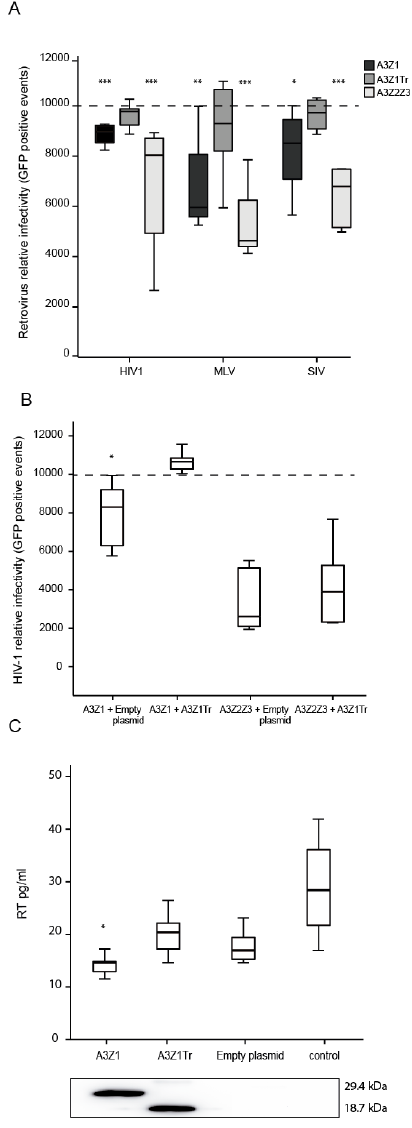
Figure 6. Retrovirus infectivity assay. ( A ) Relative infectivity of HIV-1, MLV and SIV-GFP pseudoviruses produced in the presence of A3Z1 (black bars), A3Z1Tr (dark grey bars) and A3Z2Z3 (light grey bars). Data are relative to the infectivity obtained with empty plasmid (discontinued line). Values are the median ( ± interquartile range) of at least three independent experiments, significantly lower (* p < 0.05; ** p < 0.01; *** p < 0.001) compared to empty plasmid; paired Mann-Whitney U Test); ( B ) relative infectivity of HIV-1 pseudoviruses produced in presence of A3Z1 and A3Z2Z3 supplemented with empty plasmid (control) or A3Z1Tr (spliced variant). Data are relative to the infectivity obtained with empty plasmid (discontinued line). Values are the median ( ± interquartile range) of at least three independent experiments, significantly lower (* p < 0.05) compared to empty plasmid; paired Mann-Whitney U Test); ( C ) RT activity values (pg/mL) upon MVV-like infection in TIGEF (0.5 MOI) expressing A3Z1, A3Z1Tr, empty plasmid and control cells (upper panel). HA-tag detection after 48 h post transfection (lower panel). Values are the median ( ± interquartile range) of at least three independent experiments, significantly lower (* p < 0.05) paired Mann-Whitney U